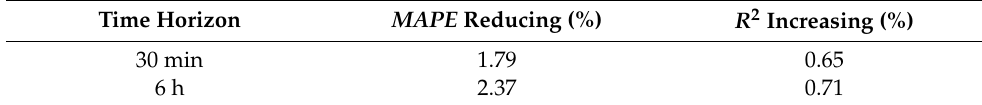
Figure 7. Load forecasting by the SVR model with 30-min time horizon. Table 13. SVR MAPE and R 2 with both time horizons after feature selection.